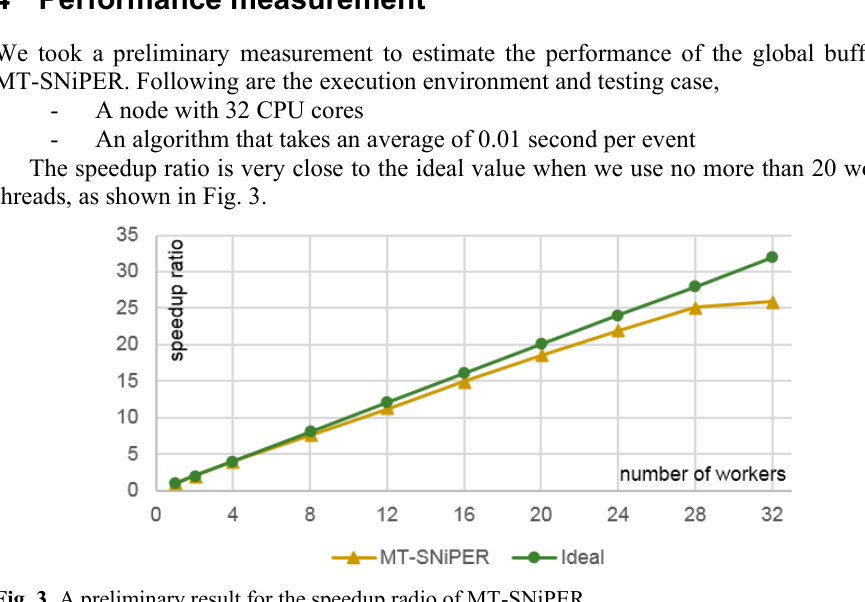
Fig. 3. A preliminary result for the speedup radio of